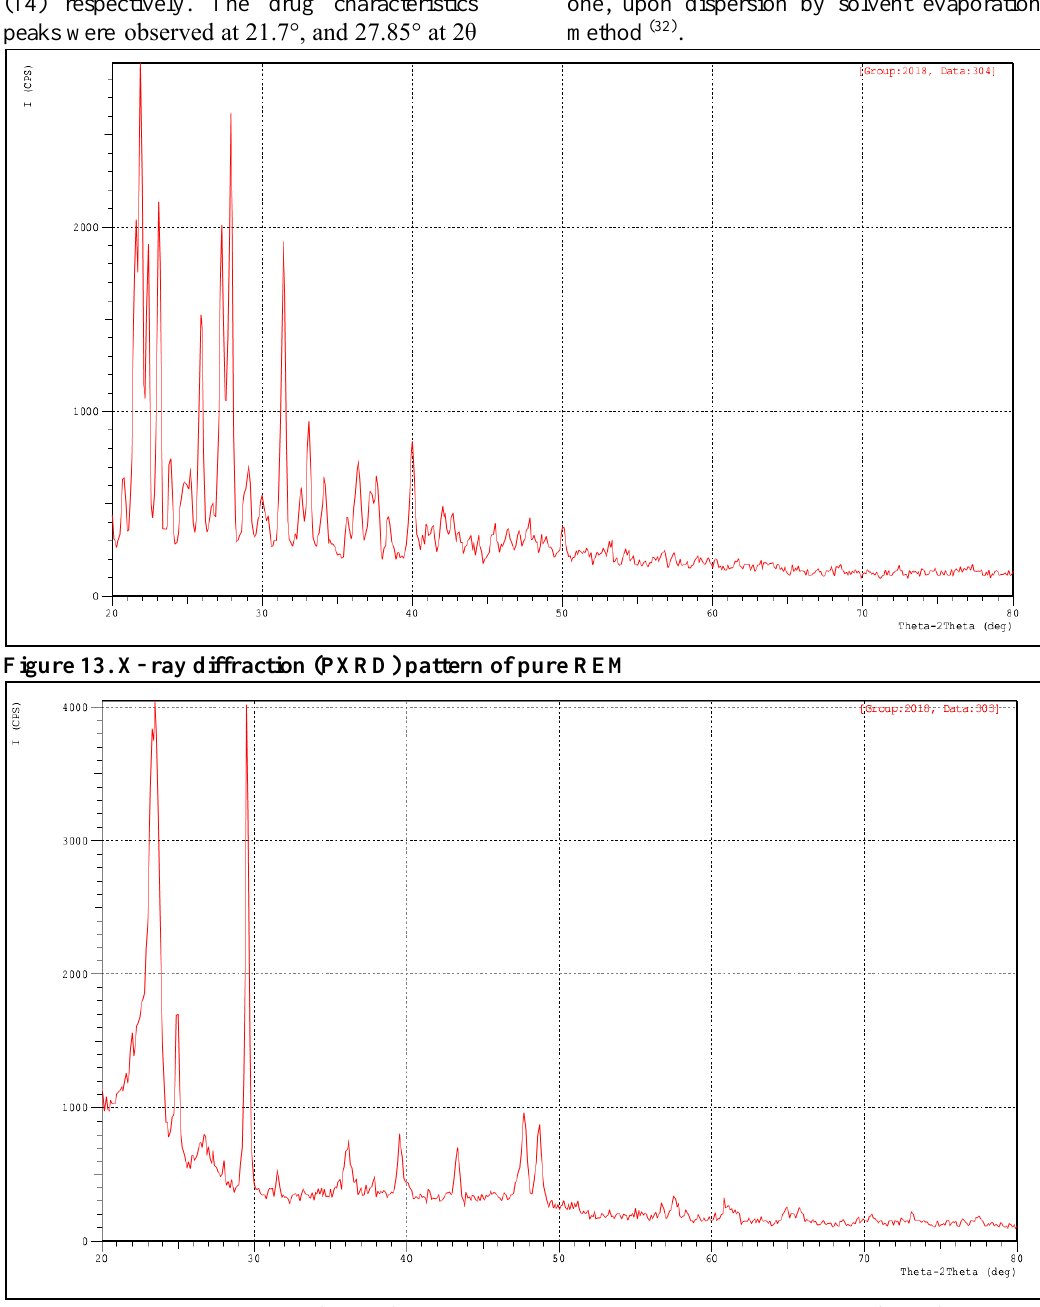
Figure 14. X- ray diffraction (PXRD) pattern of selected formula of REM- TPGS (SD30) scanning electron microscopy